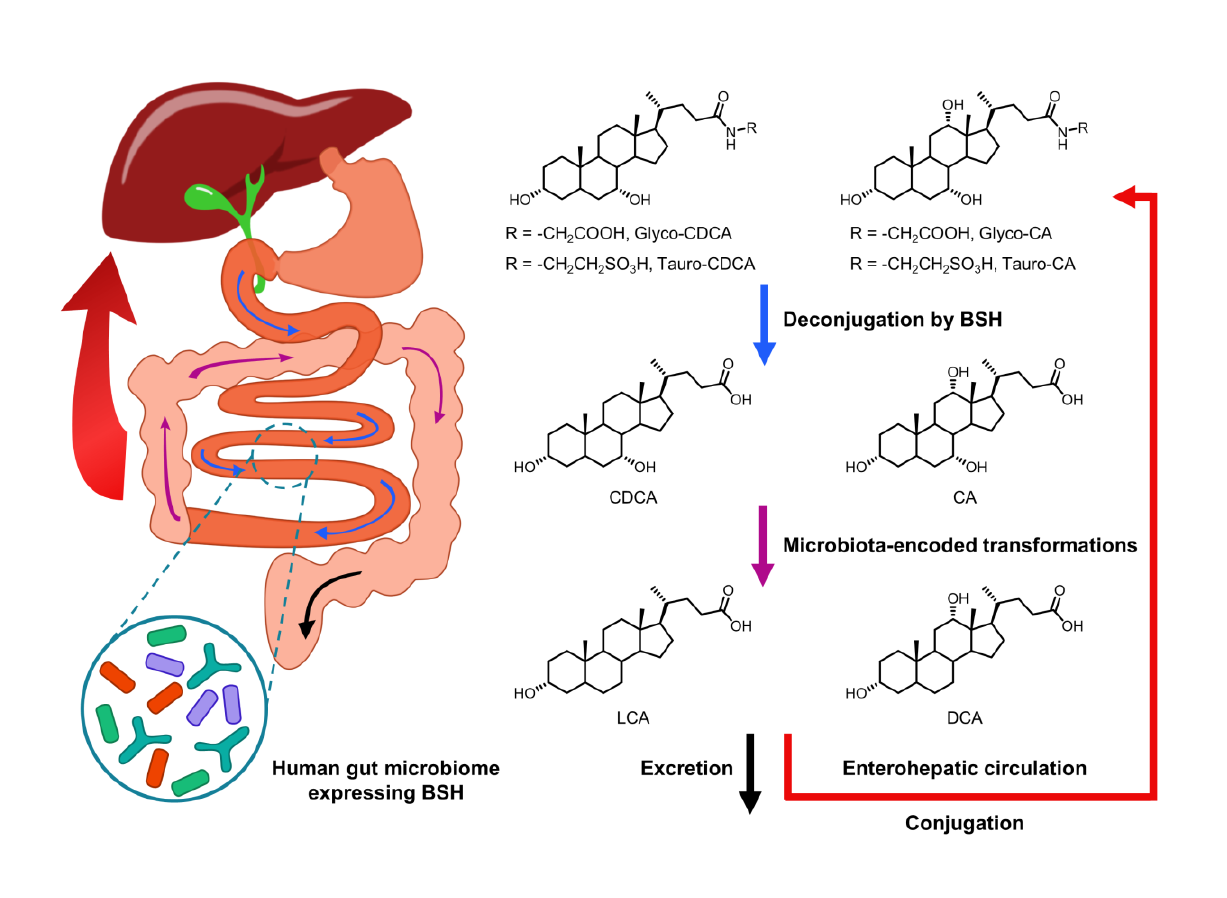
FIGURE 10: Biotransformation of bile acids by BSH-containing gut